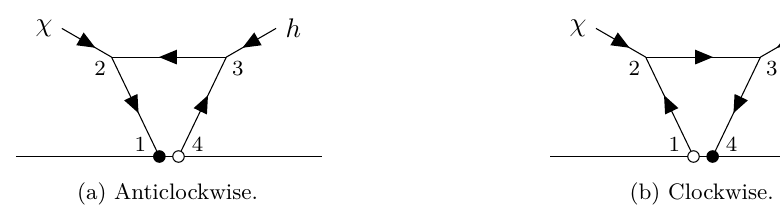
Figure 10 . The BRST variation of subfigure 8a gives a boundary term on the defect. Since we are taking the external legs to be distinct, there are now two contributing